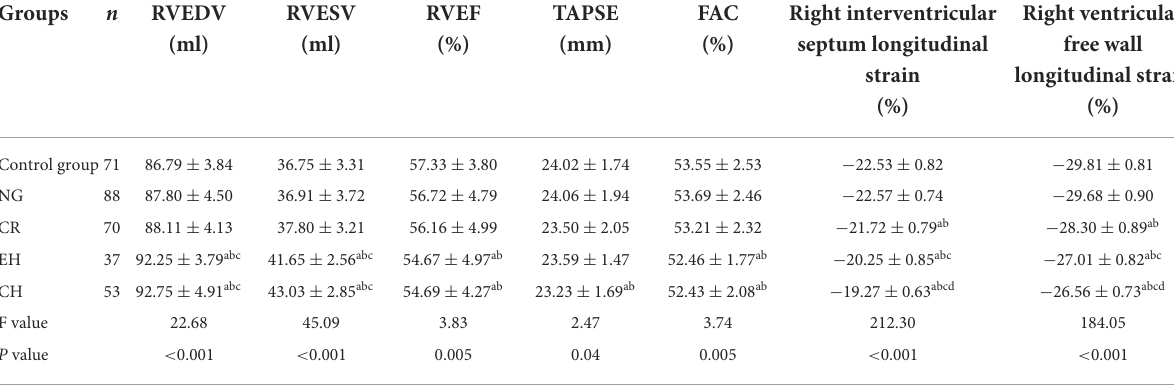
TABLE 3 Comparison among groups in terms of right ventricular echocardiographic parameters ( x ± s).